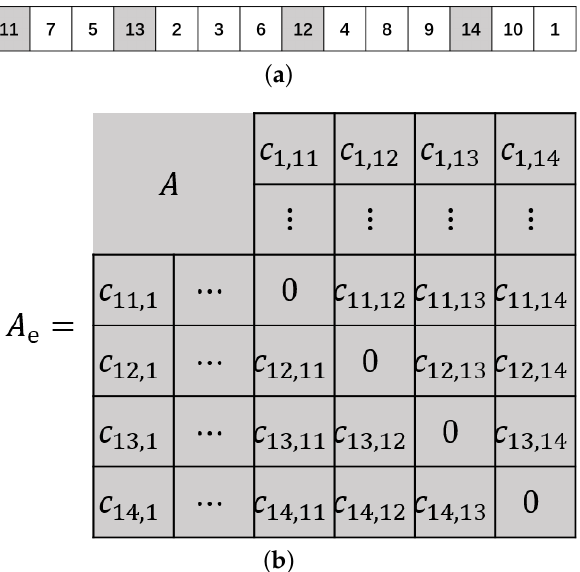
Figure 3. Example of ( a ) the proposed one chromosome representation and ( b ) the extended cost